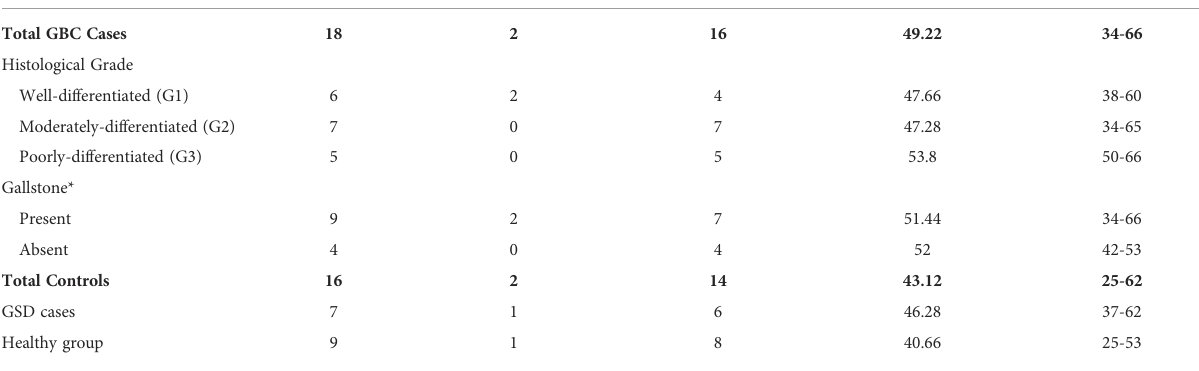
TABLE 1 Clinical samples used in the study.